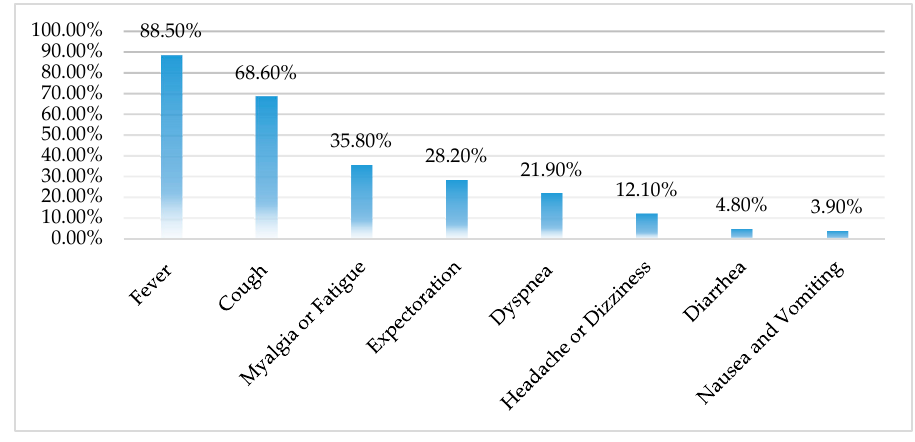
Figure 2. The clinical symptoms of COVID-19.